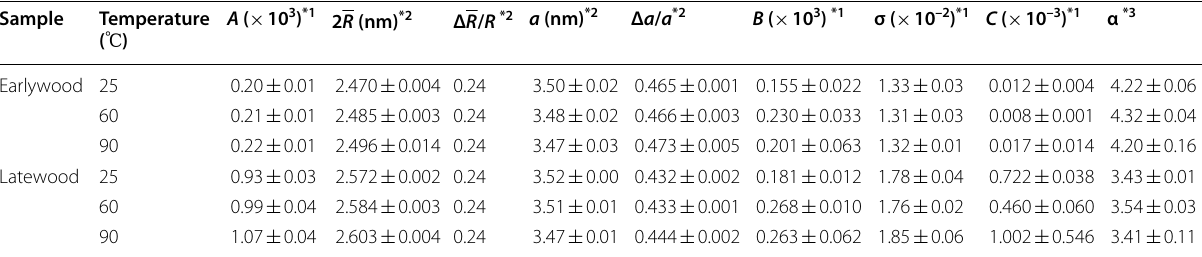
*1 Constants for each term of Eq. (1) *2 Radius ( R ) and distance ( a ) of hexagonally packed cylinders and their respective coefficients of variation *3 Exponent of power-law at low q See Eq. (1) for details